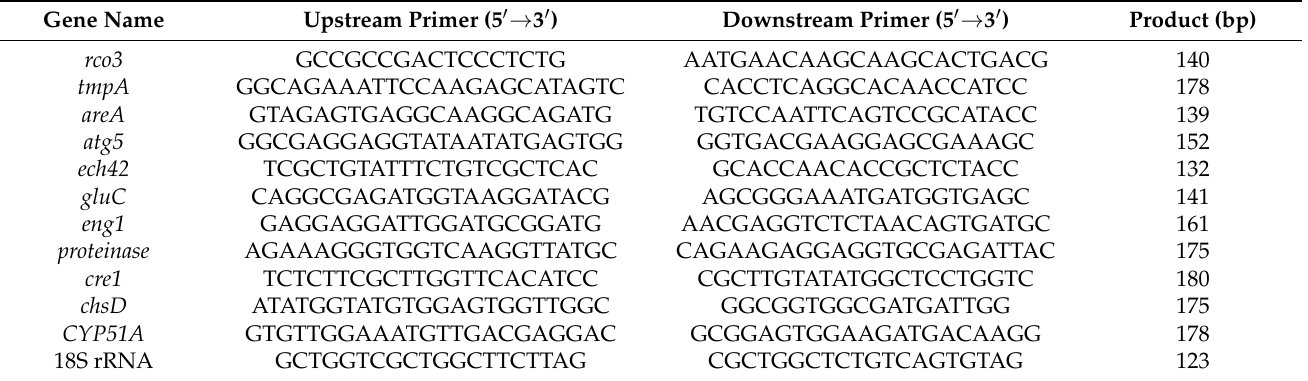
Table 1. Primers used for